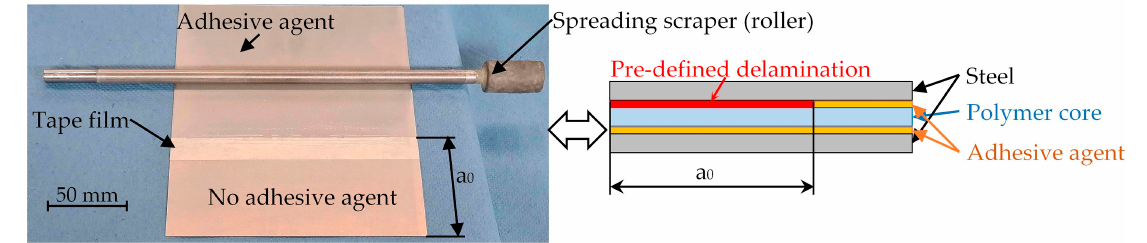
Figure 3. Layup and manufacturing of the MPM sandwich with adhesive pre-crack.